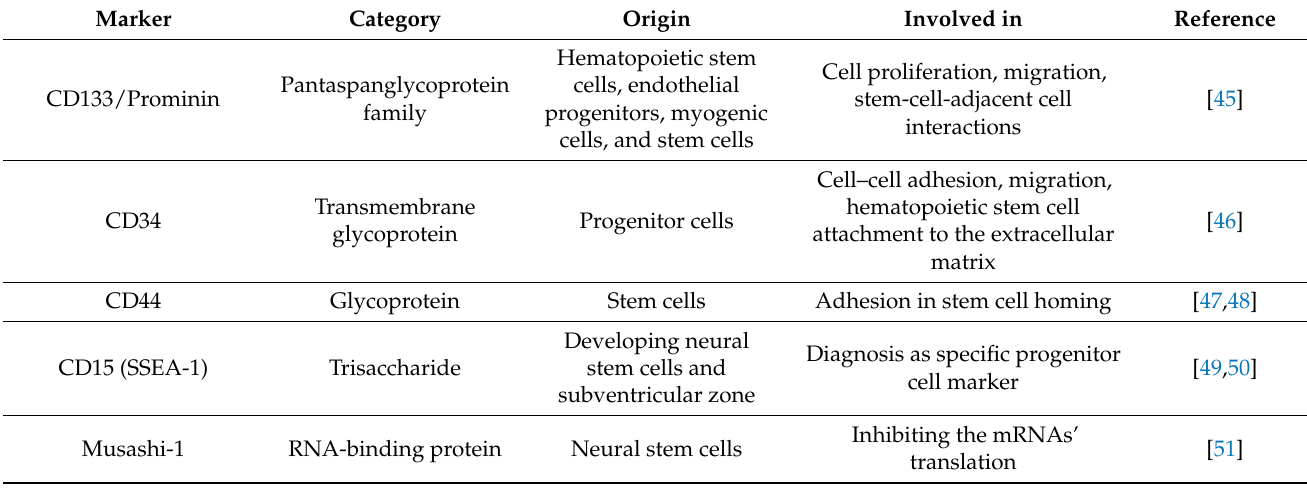
Table 1. Biomarkers of